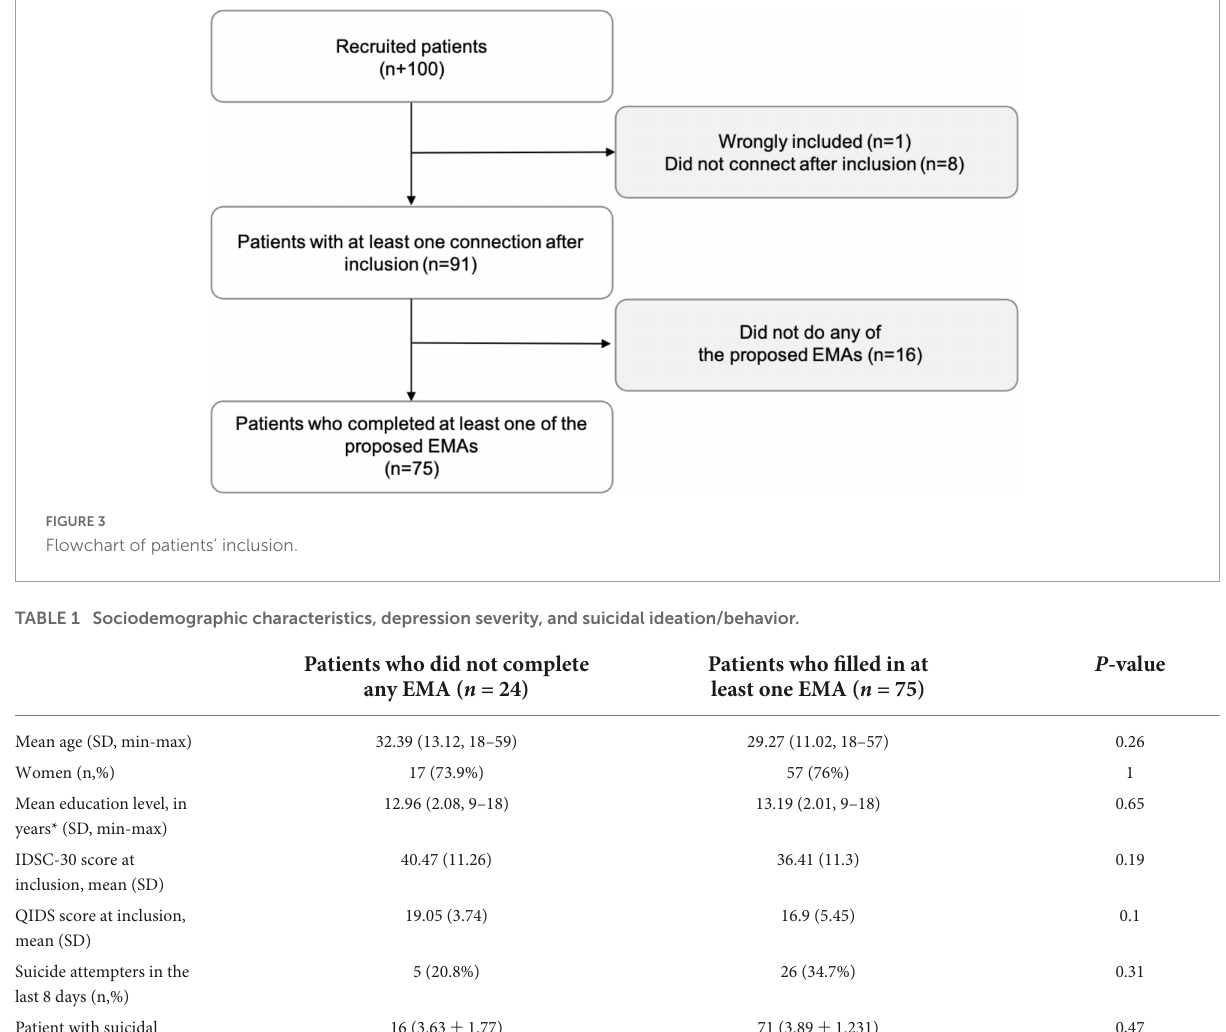
Patients who filled in at least one EMA ( n =